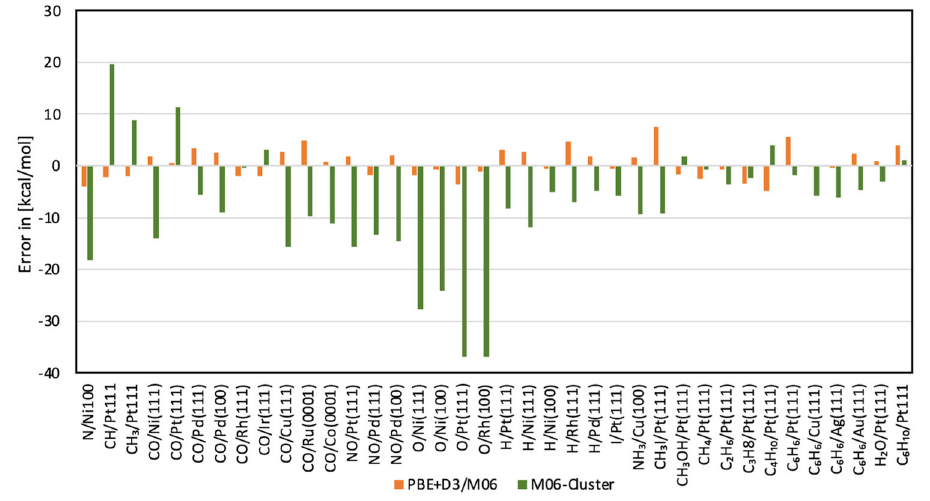
Fig. 3 | Stability of correction compared to only higher-level calculation on cluster model. Error comparison (kcalmol − 1 ) between adsorption energies using